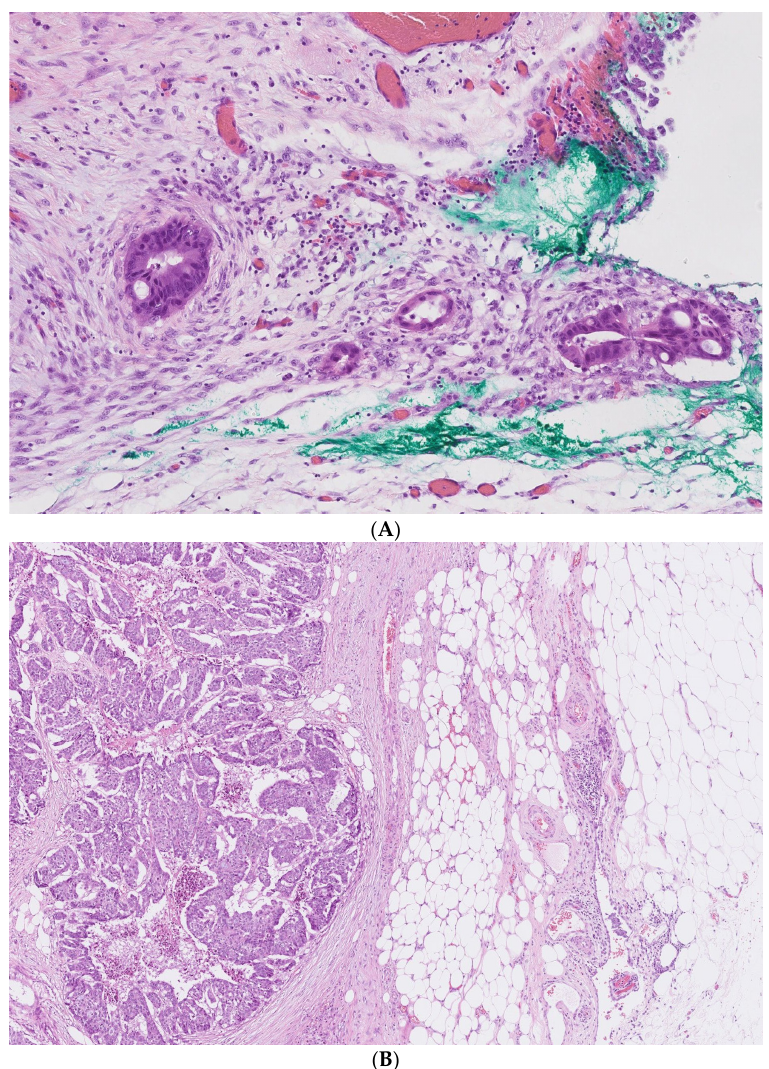
Figure 1. Serosal invasion in carcinoma (pT4a) ( A ) and carcinoma showing invasion into pericolic connective tissues without serosal invasion (pT3) ( B ). 3.2. Expression of miR-200 Family and Its Target Genes in Carcinoma with and without Serosal Invasion Compared to Normal Mucosa